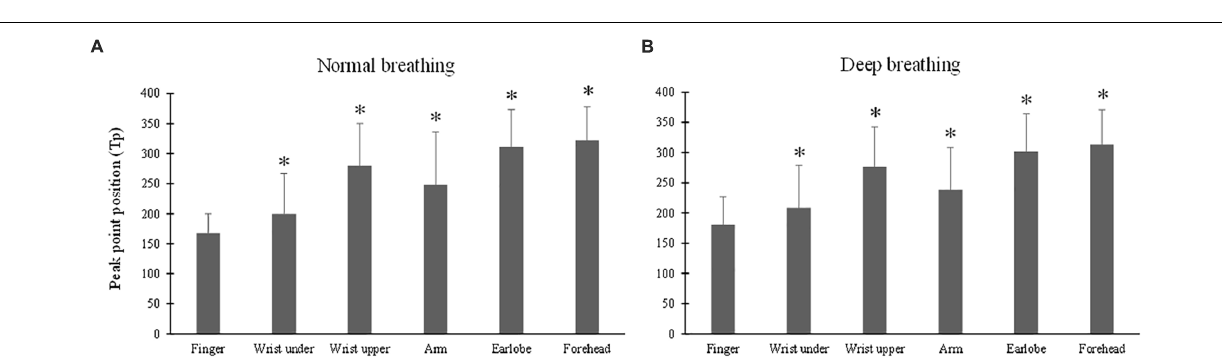
Frontiers in Physiology |